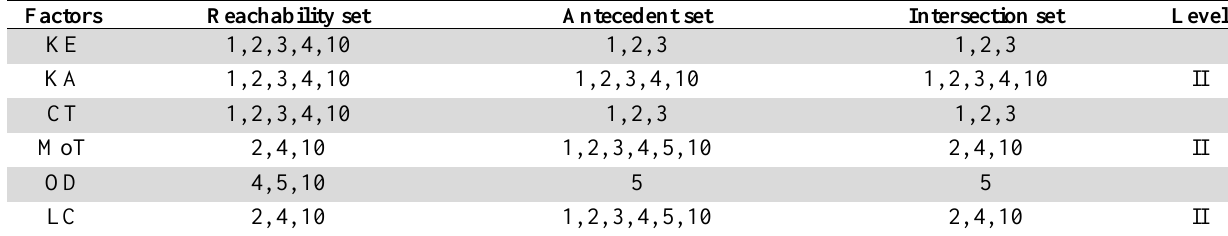
Level partition—iteration 2